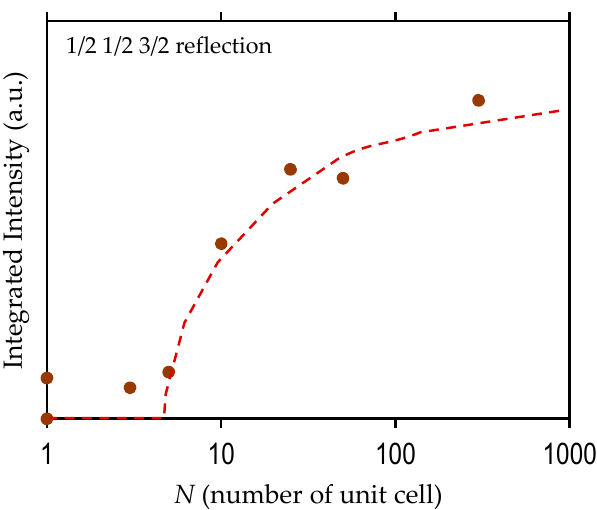
Figure 3. Integrated intensity of 1/2 1/2 3/2 reflection in the XRD-RSMs as a function of N , where N denotes the number of ABO 3 unit cells in the two layers of Mn-BiFeO 3 and BaTiO 3 comprising the superlattice. We confirmed that the integrated intensity of 1/2 1/2 3/2 reflection of the pristine Mn-BiFeO 3 film (300 unit cell thickness) is almost the same as that for N = 300.